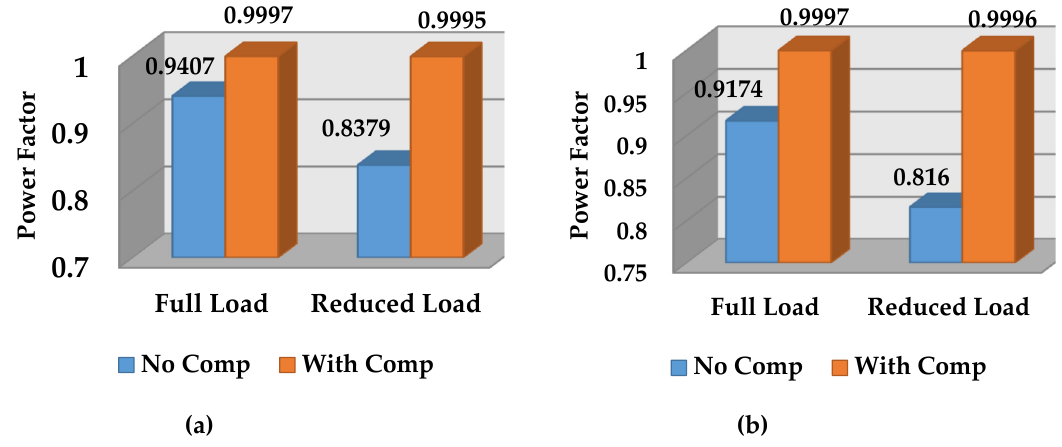
Figure 22. True power factor at PCC using MB-HCC: ( a ) ideal grid condition; ( b ) distorted grid condition. Table 7. RT results